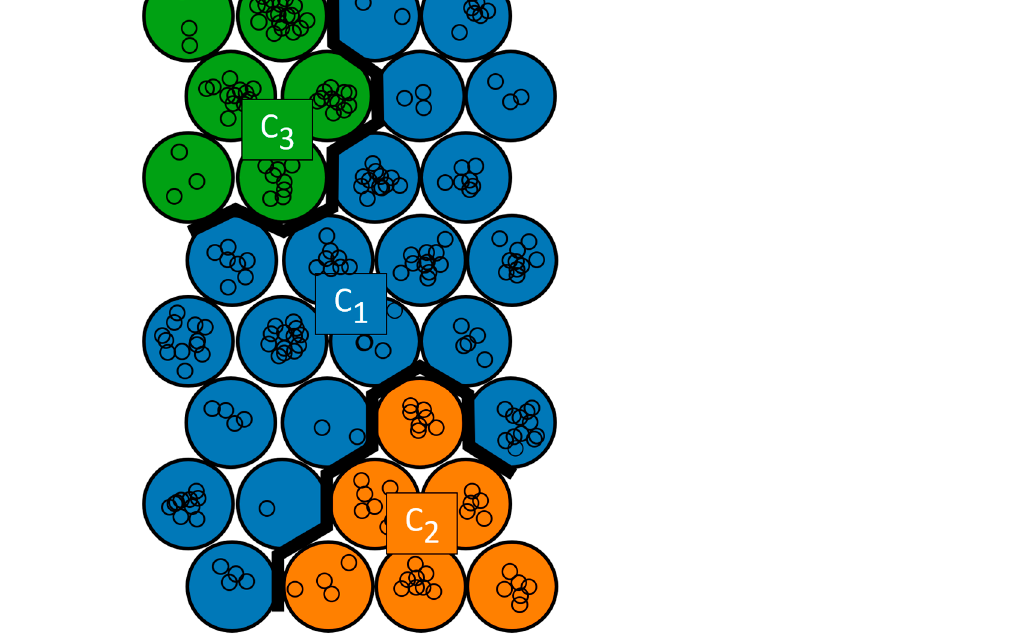
Figure 7. Clustered SOM. Each color represents a different cluster. The black circles correspond to the individual samples that were included in each neuron. From C1 to C3: result of the three clusters obtained.